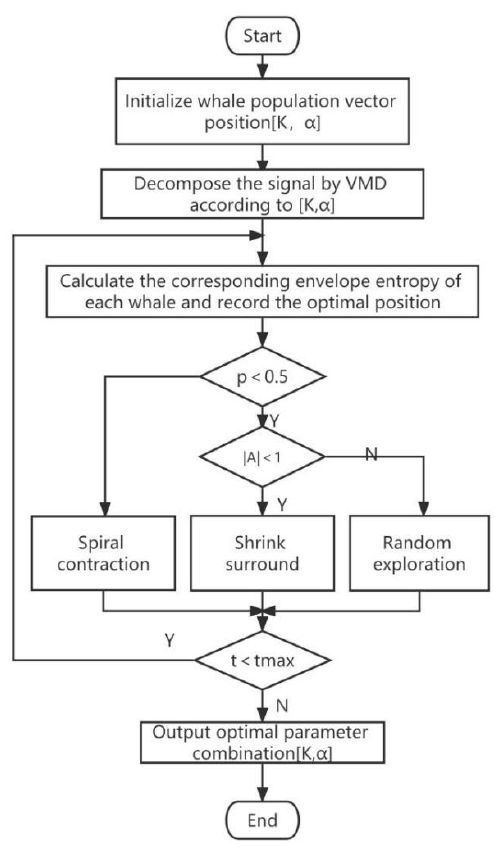
Figure 1. A flowchart of the WOA-optimizing VMD